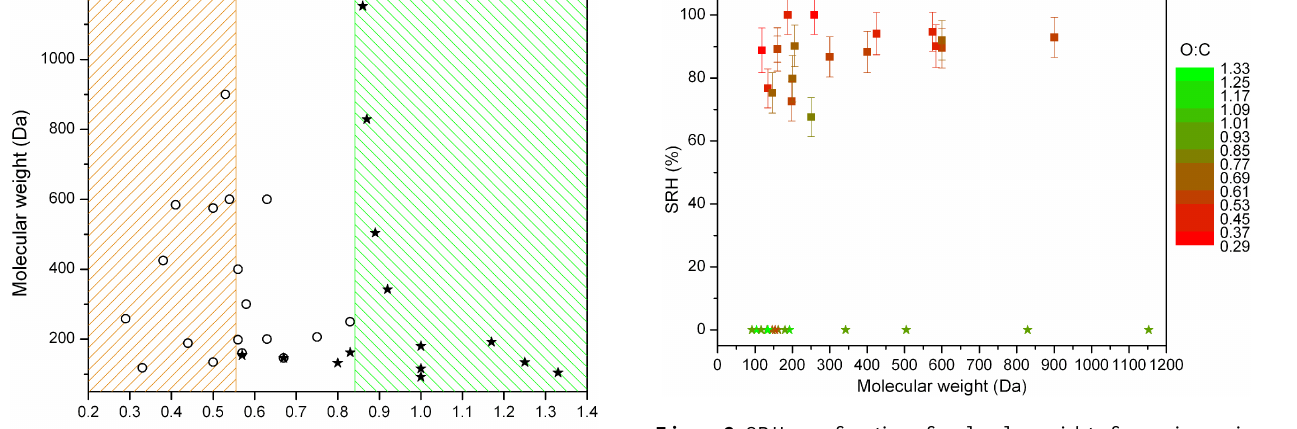
Figure 2. SRH as a function of molecular weight of organic species in the particles at 290 ± 1K. The SRH results are from the current study and You et al. (2013) (see Table 3). The colors represent the O:C of different organic species. Squares represent SRH of par- ticles in which liquid–liquid phase separation was observed. Bars for the squares are 95% confidence intervals considering σ of mul- tiple SRH measurements and the uncertainty from the calibration. Stars indicate that liquid–liquid phase separation was not observed. OIR = 2.0 ± 0.1 in all the